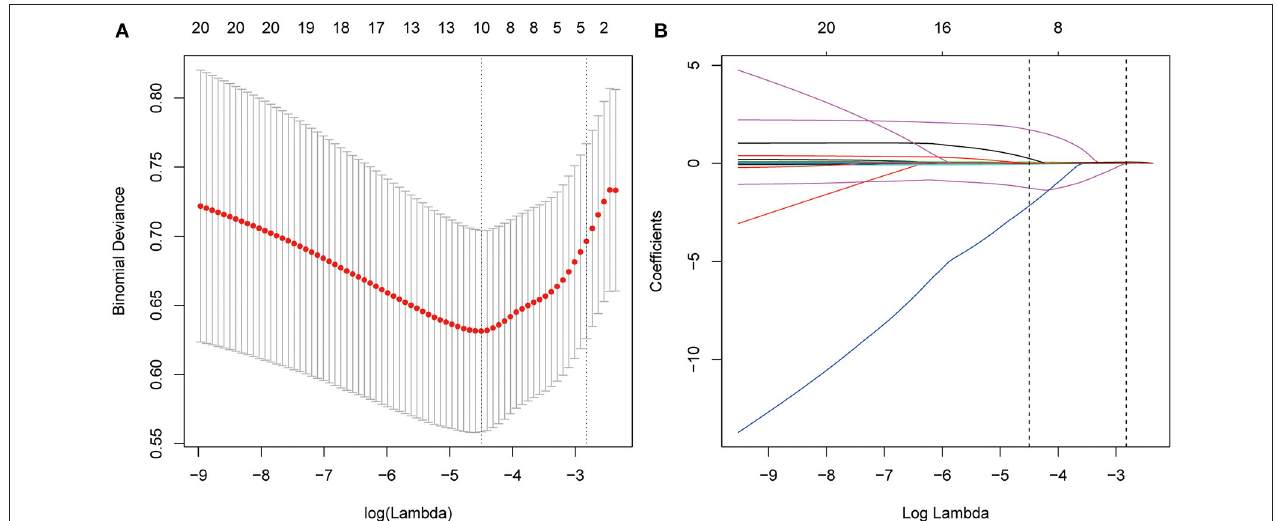
FIGURE 2 | Texture feature selection using the least absolute shrinkage and selection operator (LASSO) binary logistic regression model. (A) Tuning parameter ( λ ) selection in the LASSO model used 10-fold cross-validation via minimum criteria. Dotted vertical lines were drawn at the optimal values by using the minimum criteria and the 1 standard error of the minimum criteria (the 1-SE criteria). A λ value of 0.0111, with log ( λ ), − 4.4982 was chosen (1-SE criteria) according to 10-fold cross-validation. (B) LASSO coefficient profiles of the 12 texture features. A coefficient profile plot was produced against the log ( λ ) sequence. Vertical line was drawn at the value selected using 10-fold cross-validation, where optimal one resulted in 4 nonzero coefficients.